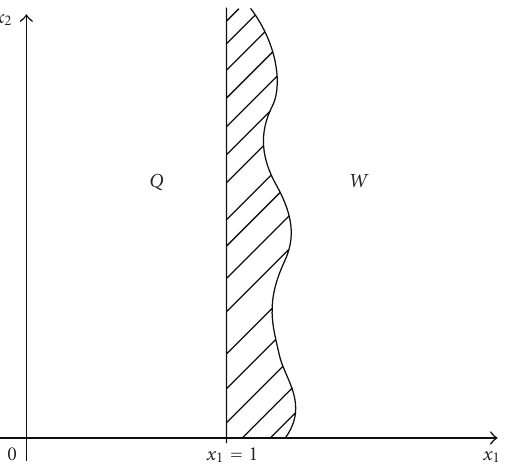
Figure 3: Region, which is guaranteed by Lemma 9.